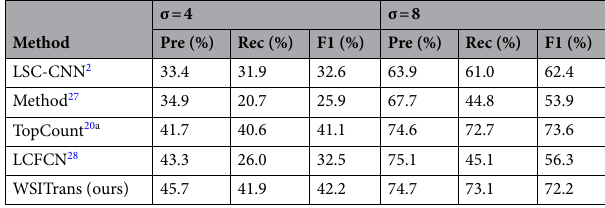
Table 5. Localization performance on the ShanghaiTech PartA dataset. a Means the methods rely on box-level instead of point-level